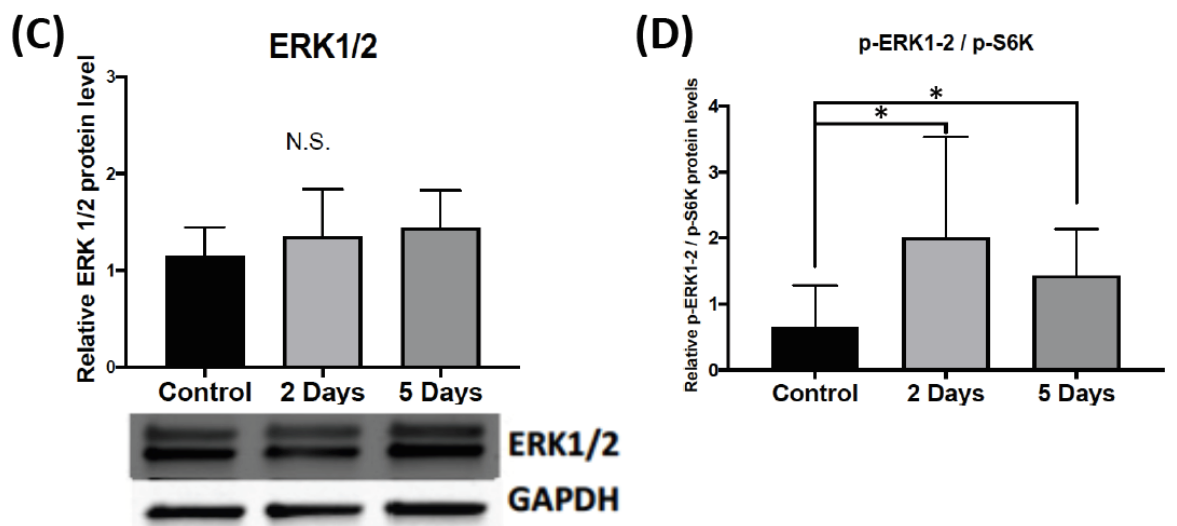
Figure 2. The effect of aggressive interactions on the phosphorylation and the expression of intracellular signaling molecules that regulate Fragile X Mental Retardation Protein (FMRP) in the nucleus accumbens (NAc). ( A ) There is no change in the phosphorylation of ribosomal S6 kinase (S6K) (phosphorylates FMRP) in the NAc 10 min following either 2 or 5 consecutive days of aggressive interactions compared to control female Syrian hamsters that had no social interaction experience (N.S.). ( B ) There is an increase in the phosphorylation of extracellular-signal related kinase 1/2 (ERK1/2) 10 min following 2 days of aggressive interactions compared to control female Syrian hamsters that had no social interaction experience and compared to levels following 5 days of aggressive interactions (* p < 0.05). ( C ) However, there was no change in the overall protein expression of ERK1/2 in the NAc (N.S.). ( D ) There is an increase in the ratio of the phosphorylation of ERK1/2 to the phosphorylation of S6K in the NAc following two and five days of aggressive interactions compared to female hamsters that had no social interaction experience (* p < 0.05). (Control n = 7 – 8, 2 Days n = 11, 5 Days n = 11). Data are presented as mean +/ − standard deviation.